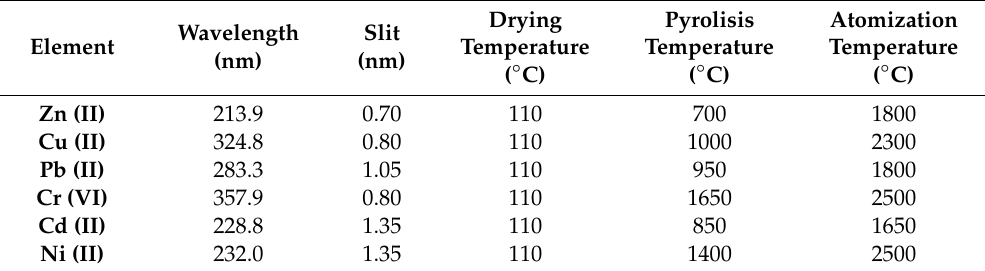
Table 1. Instrument settings for AAS